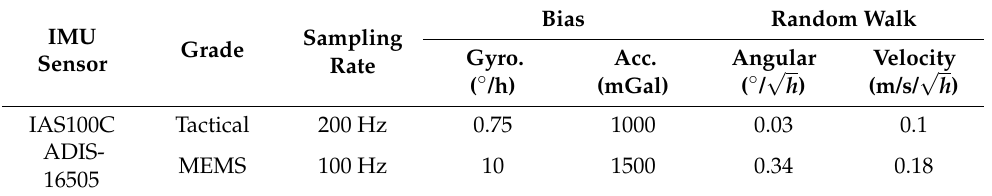
Table 1. Parameters of the IMU sensors used in the experiments.